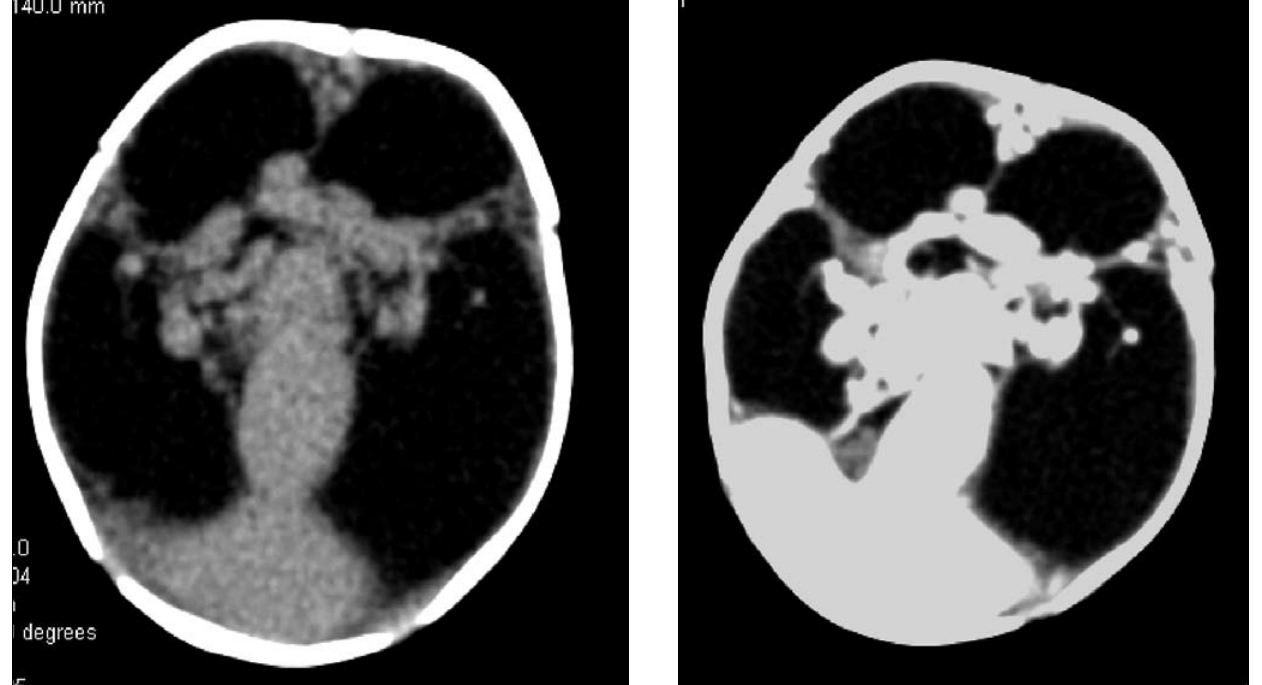
Fig. 4. Axial non-enhanced and enhanced computed tomography of the brain demonstrates dilated, tortuous vessels draining into a large vein of Galen with secondary hydrocephalus and astrogliosis with no brain